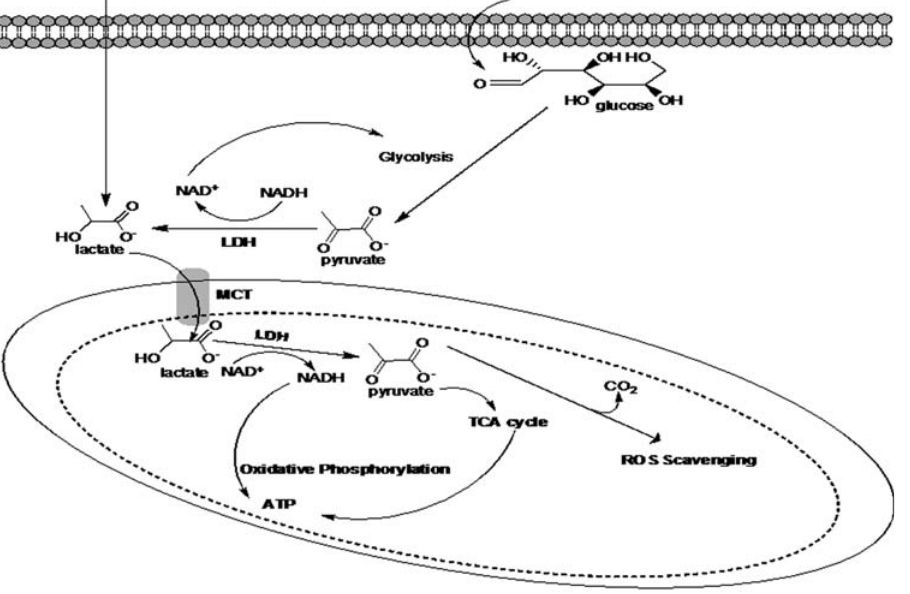
Figure 11. The versatile role of a mitochondrial LDH in an astrocytic cell line. Lactate may be obtained either directly via uptake or by conversion of glucose through the glycolytic pathways.